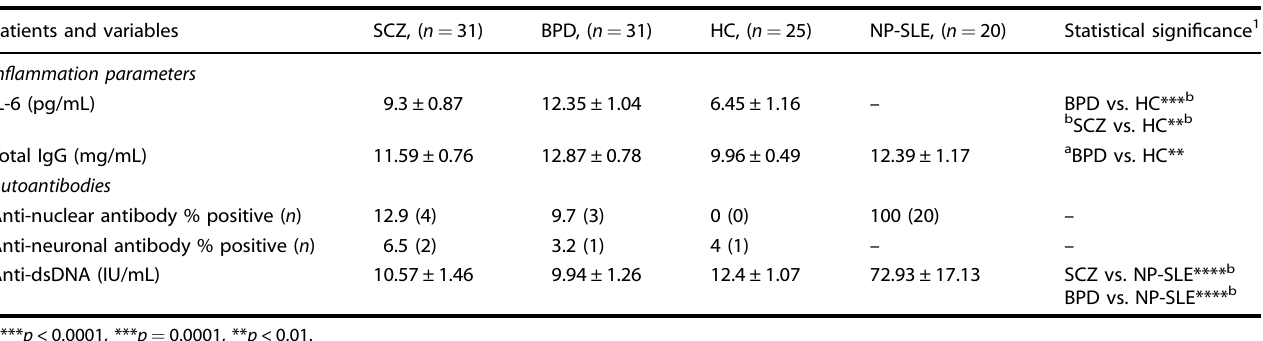
Table 2. Immunological